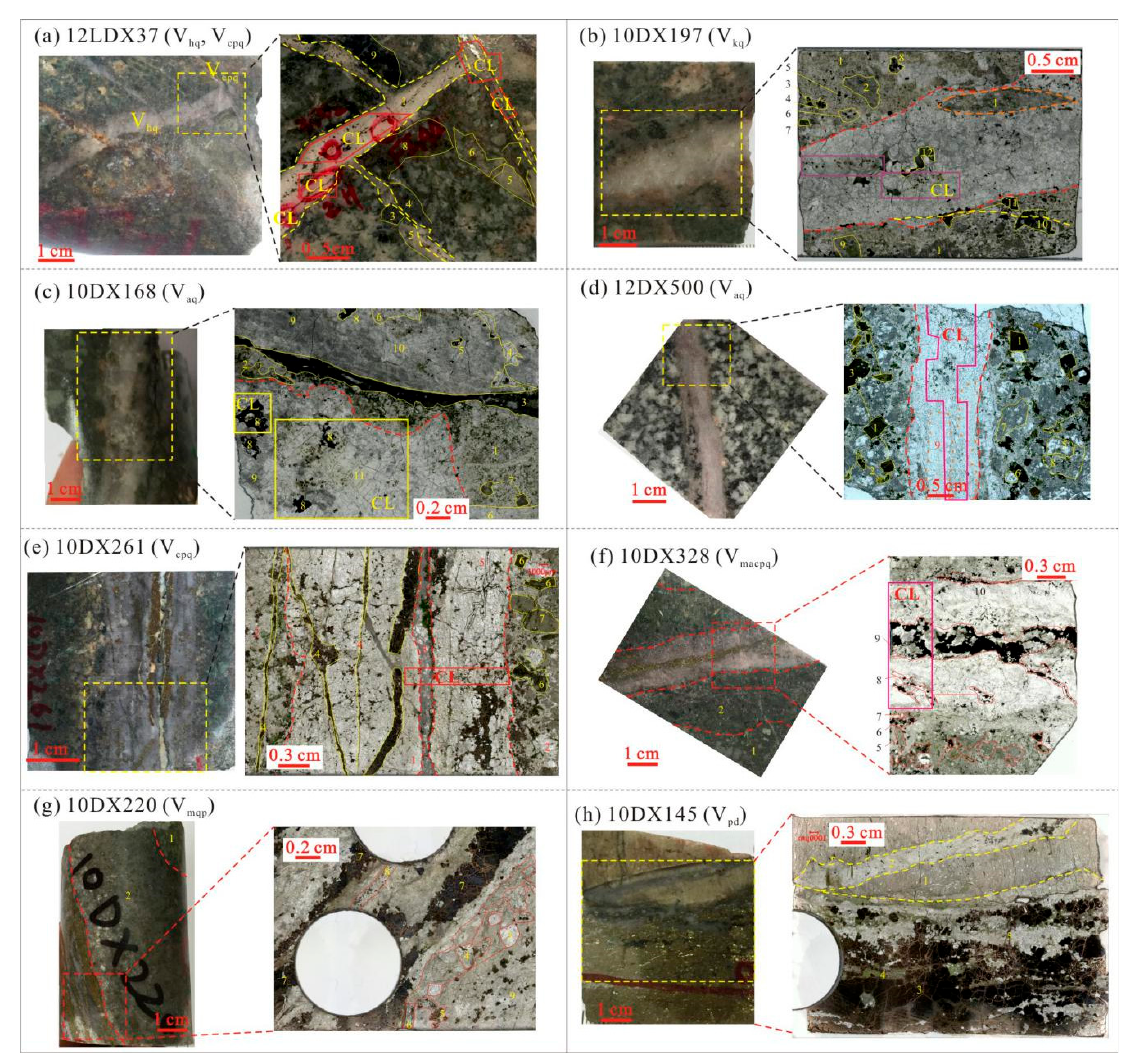
Figure A1. Petrography of studied samples. Selected vein samples and photos of the thick sections.